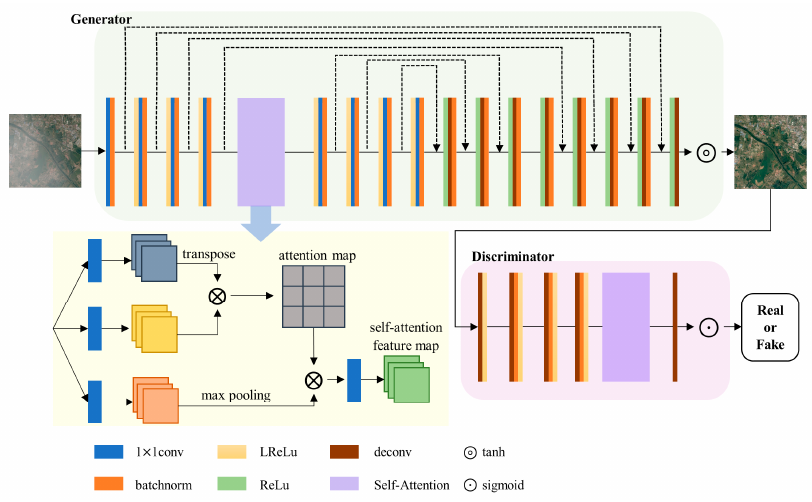
Figure 3. PAGAN structure.